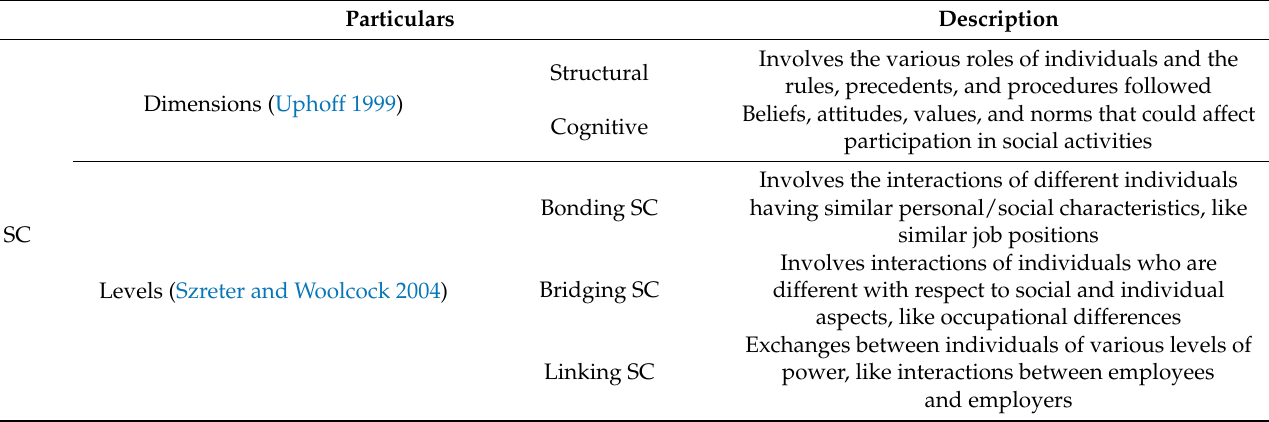
Table 2. Constituents of social capital